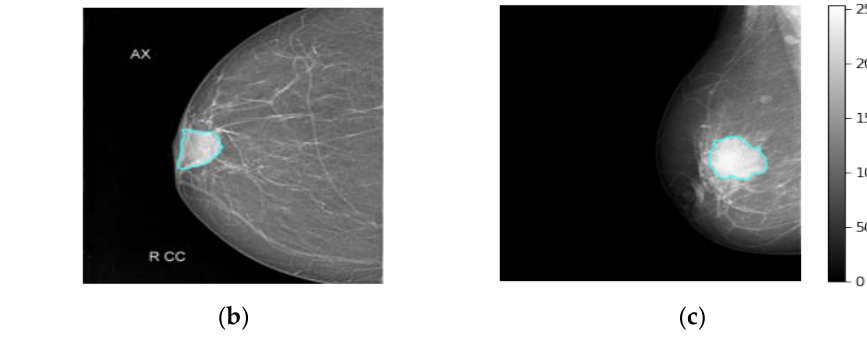
Figure 3. Some examples of real breast cancer mammograms. Normal, benign, and malignant cases are depicted in ( a ), ( b ), and ( c ), respectively. The breast lesion localization is accurately superimposed on the breast mammograms of benign and malignant cases via the cyan color counter.